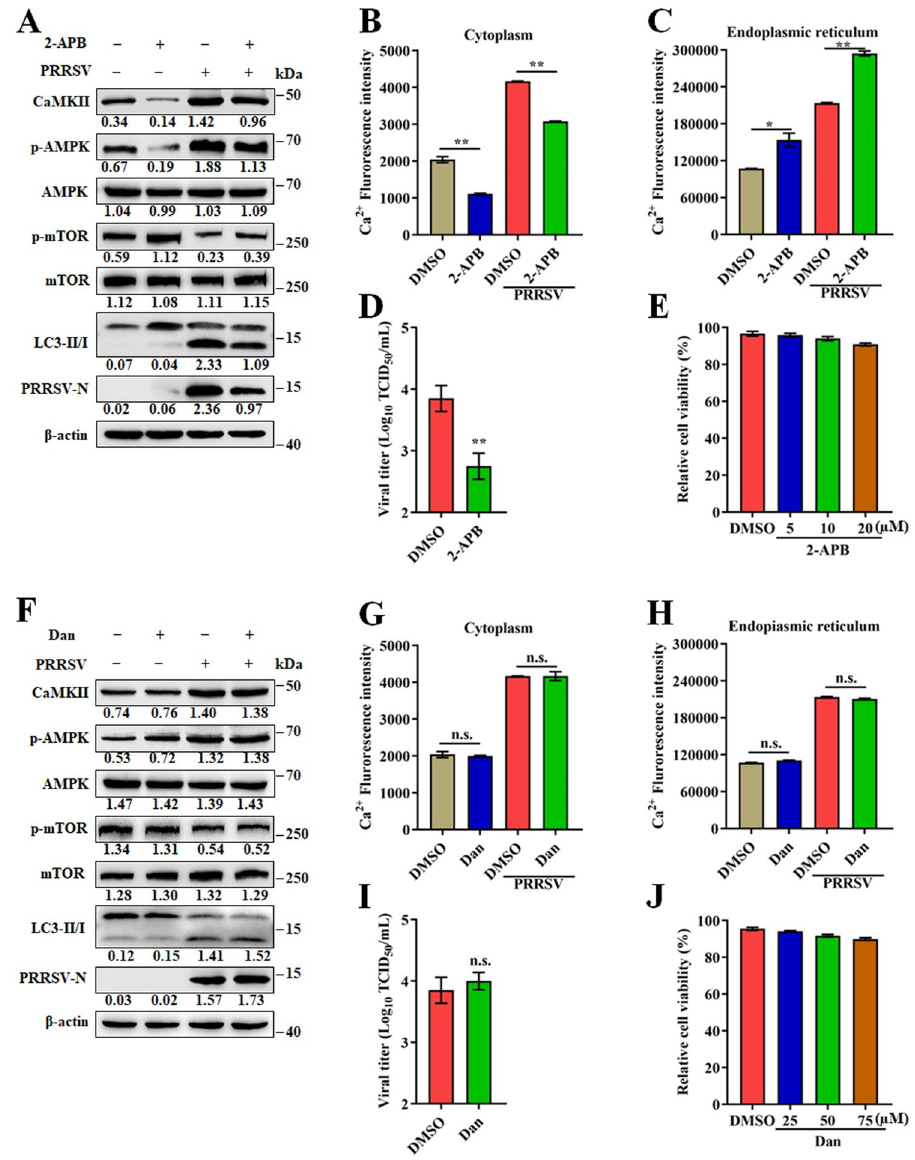
Fig 7. ER associated calcium is released into the cytoplasm from IP3R but not RyR channel. (A-E) Marc-145 cells were infected with PRRSV (MOI = 0.1) and treated with 10 μ M 2-APB or DMSO for 24 h. ( A ) Cell lysates were analyzed by western blotting for CaMKII, p-AMPK, AMPK, p-mTOR, mTOR, LC3-I/II, PRRSV-N, and β -actin. ( B ) Cytoplasmic Ca 2+ levels and ( C ) ER Ca 2+ levels were determined by fluorescence of Fluo-8. ( D ) TCID 50 of PRRSV in cell supernatants. ( E ) The effect of 2-APB on Marc-145 cell viability. Marc-145 cells were treated with 2-APB at indicated concentrations or DMSO for 24 h, then analyzed with CCK-8 system. (F-J) Marc-145 cells were infected with PRRSV (MOI = 0.1) and treated with 50 μ M dantrolene sodium or DMSO for 24 h. ( F ) Cell lysates were analyzed by western blotting for CaMKII, p-AMPK, AMPK, p-mTOR, mTOR, LC3-I/II, PRRSV-N, and β -actin. ( G ) Cytoplasmic Ca 2+ levels and ( H ) ER Ca 2+ levels were determined by fluorescence of Fluo-8. ( I ) TCID 50 of PRRSV in cell supernatants. ( J ) The effect of Dantrolene sodium on Marc-145 cell viability. Marc-145 cells were treated with Dantrolene sodium at indicated concentrations or DMSO for 24 h, then analyzed with CCK-8 system. The protein levels were quantified by Image J and normalized to β -actin. The data are representative of results from three independent experiments. Error bars indicate the mean ( ± SD) of three repeats. * , p < 0.05; ** , p < 0.01; and *** , p <